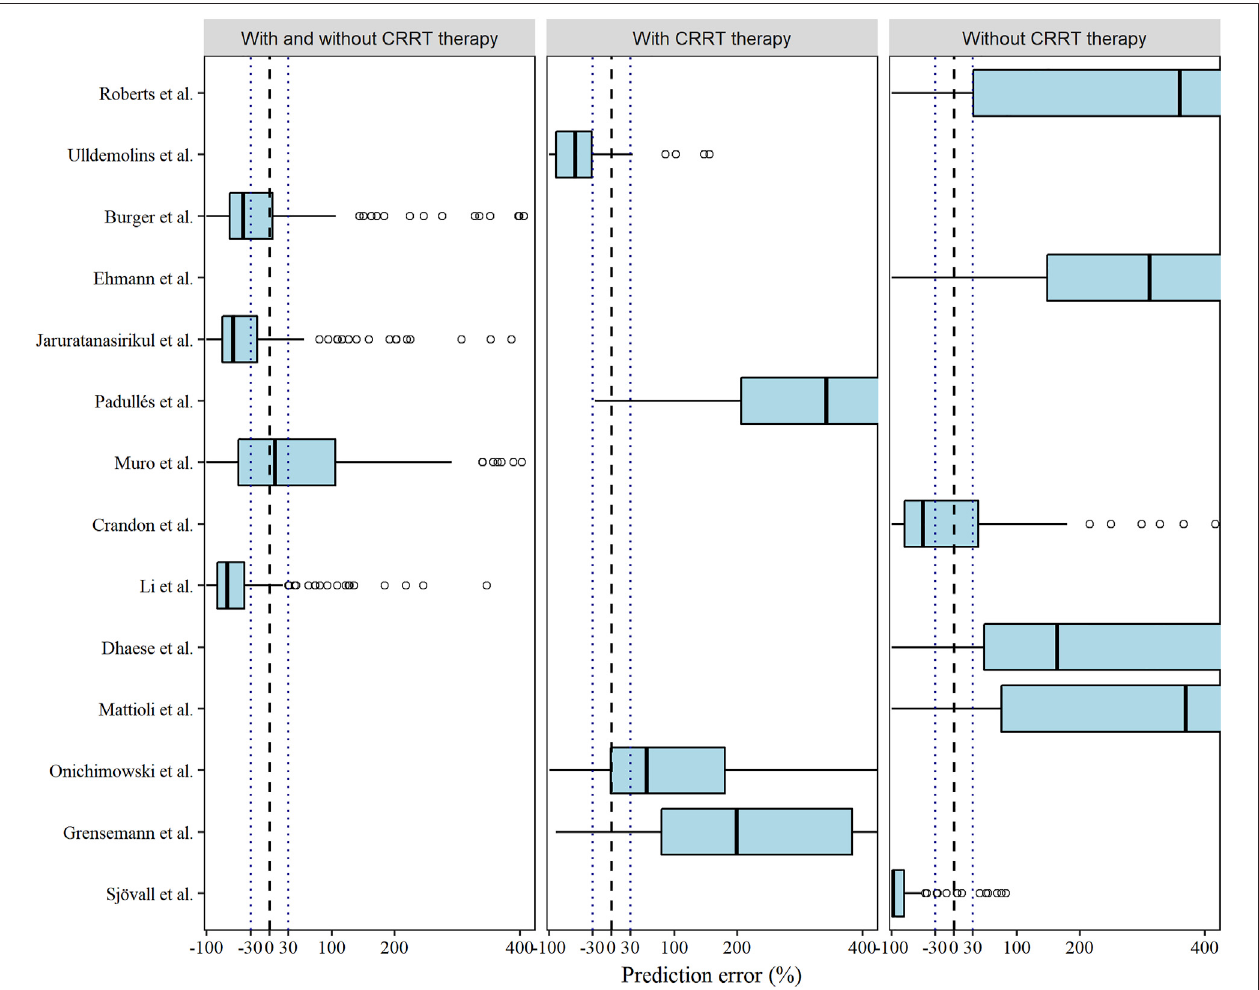
FIGURE 2 | Box plots of the prediction error (PE %) of the studied meropenem models. Black dashed and dotted lines are reference lines indicating PE% of 0% or ±30%, respectively.